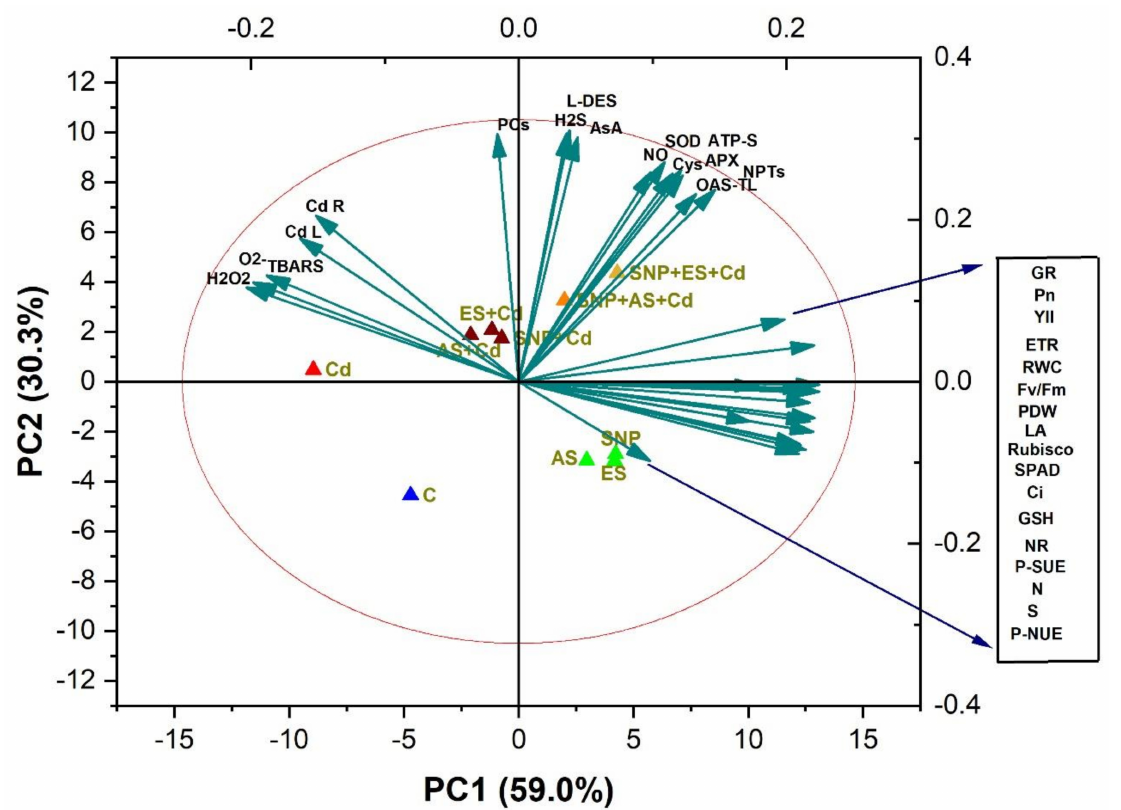
Figure 7. Biplots of principal component analysis (PCA) represent the relationship among different variables and treatments in mustard ( Brassica juncea L. cv. Giriraj) treated with 100 µ M SNP (NO donor) and 200 mg S kg − 1 soil of elemental sulfur (ES) or ammonium sulfate (AS) in the presence or absence of 200 mg Cd kg − 1 soil. The variables included net photosynthesis (P N ), intercellular CO 2 concentration (Cint), Rubisco activity, reduced glutathione (GSH), ATP-sulfurylase (ATP-S), O -acetylserine (thiol) lyase (OAS-TL) nitrate reductase (NR), fresh weight (FW), dry weight (DW), glutathione reductase (GR), non-protein thiols (NPT), nitric oxide (NO), hydrogen sulfide (H 2 S), L-cysteine dedulfhydrase (L-DES), ascorbate (AsA), dehydroasorbate reductase (DHAR), superoxide dismutase (SOD), ascorbate peroxidase (APX), phytochelatins (PCs), cadmium root (Cd R), cadmium leaf (Cd L), H 2 O 2 content, electrolyte leakage (EL), superoxide content (O 2 ), and thiobarbituric acid reactive substances (TBARS)